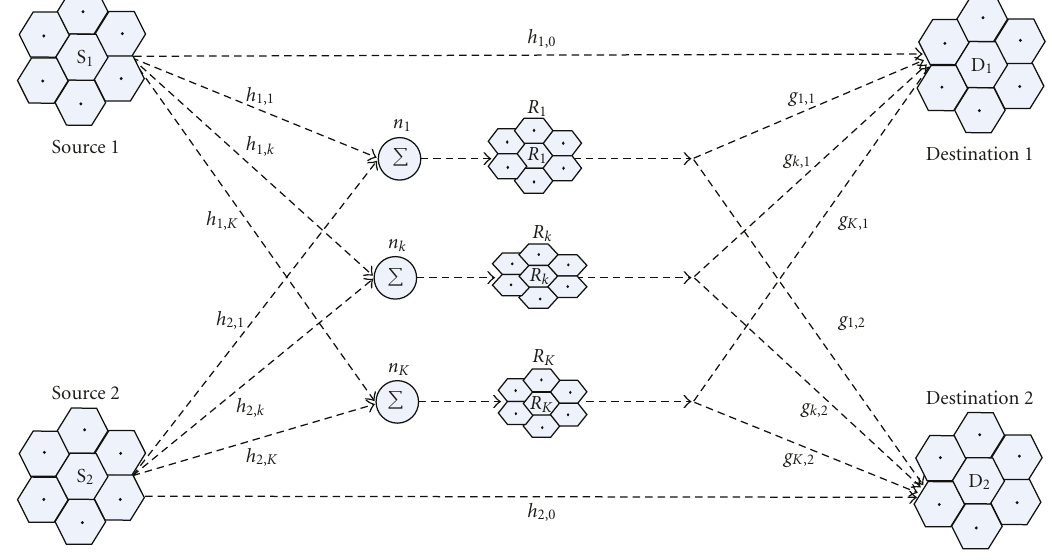
Figure 2: The system model for the lattice-based network